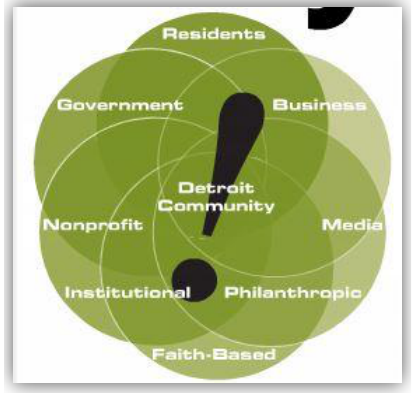
Figure 1. Segments of community. (Image credit: Detroit Collaborative Design